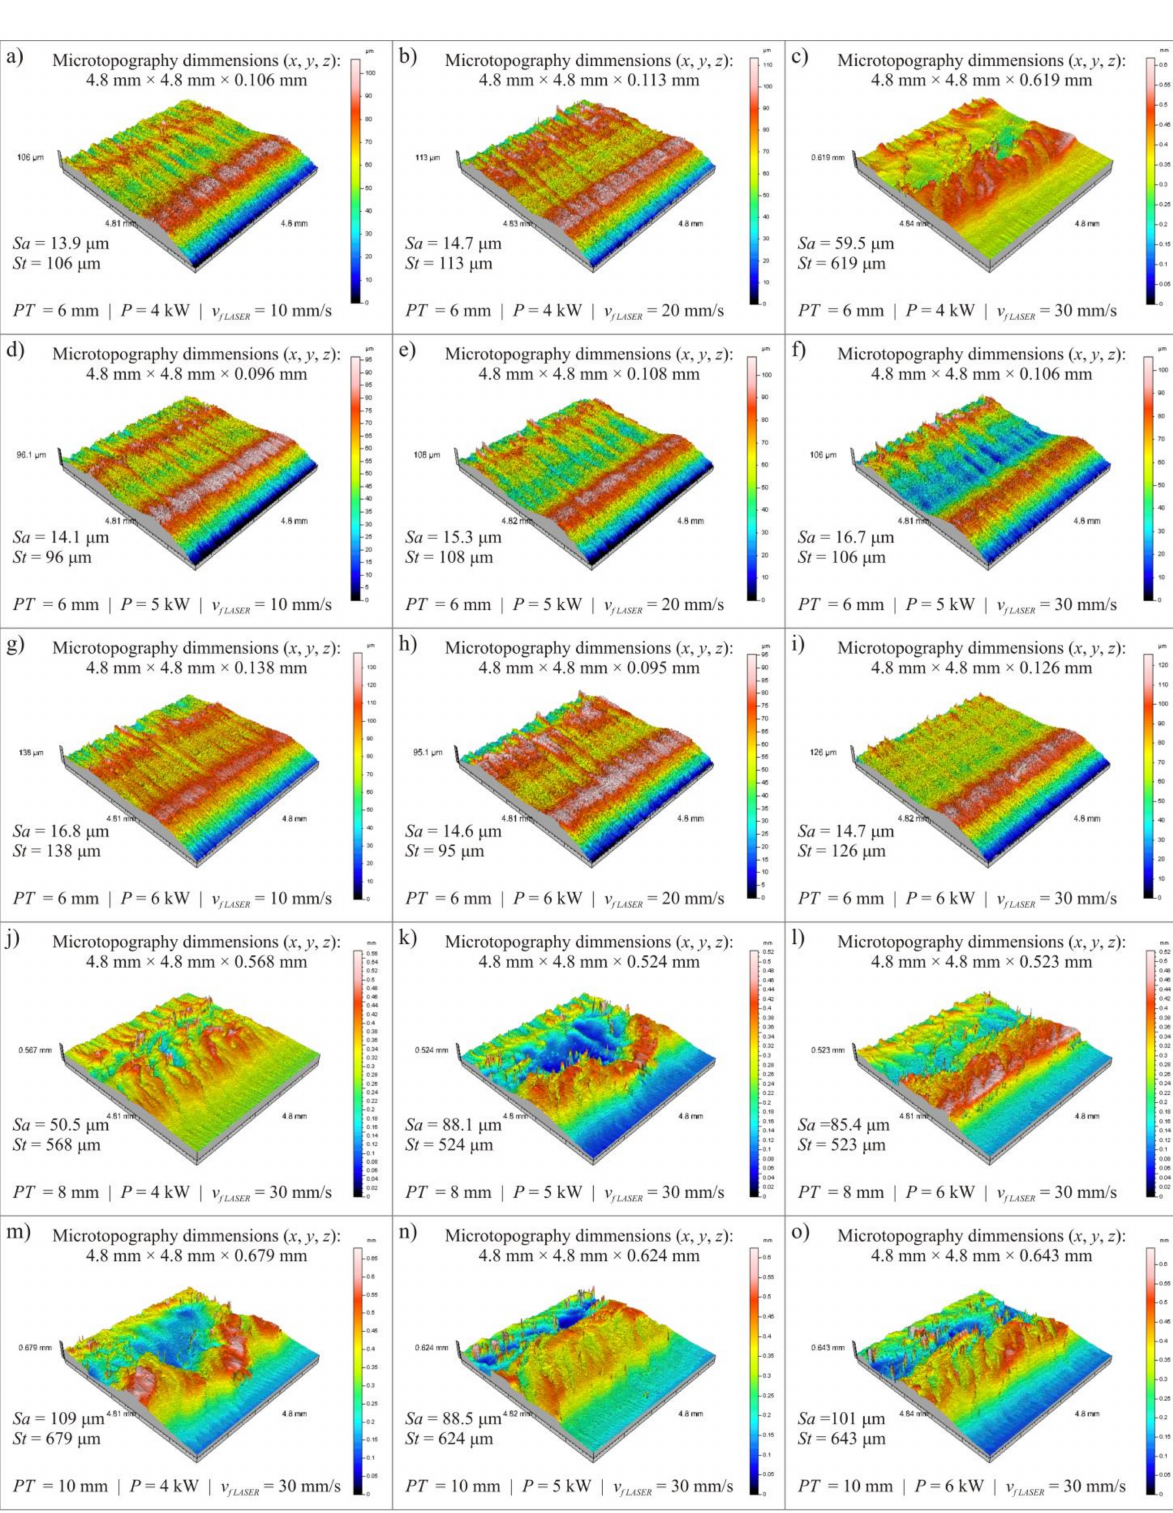
Figure 2. An overview of selected microtopographies of cut surfaces of elements cut by laser cutting: ( a – i ) PT = 6 mm, P = 4, 5, 6 kW, v f LASER = 10, 20, 30 mm/s; ( j – l ) PT = 8 mm, P = 4, 5, 6 kW, v f LASER = 30 mm/s; ( m – o ) PT = 10 mm, P = 4, 5, 6 kW, v f LASER = 30